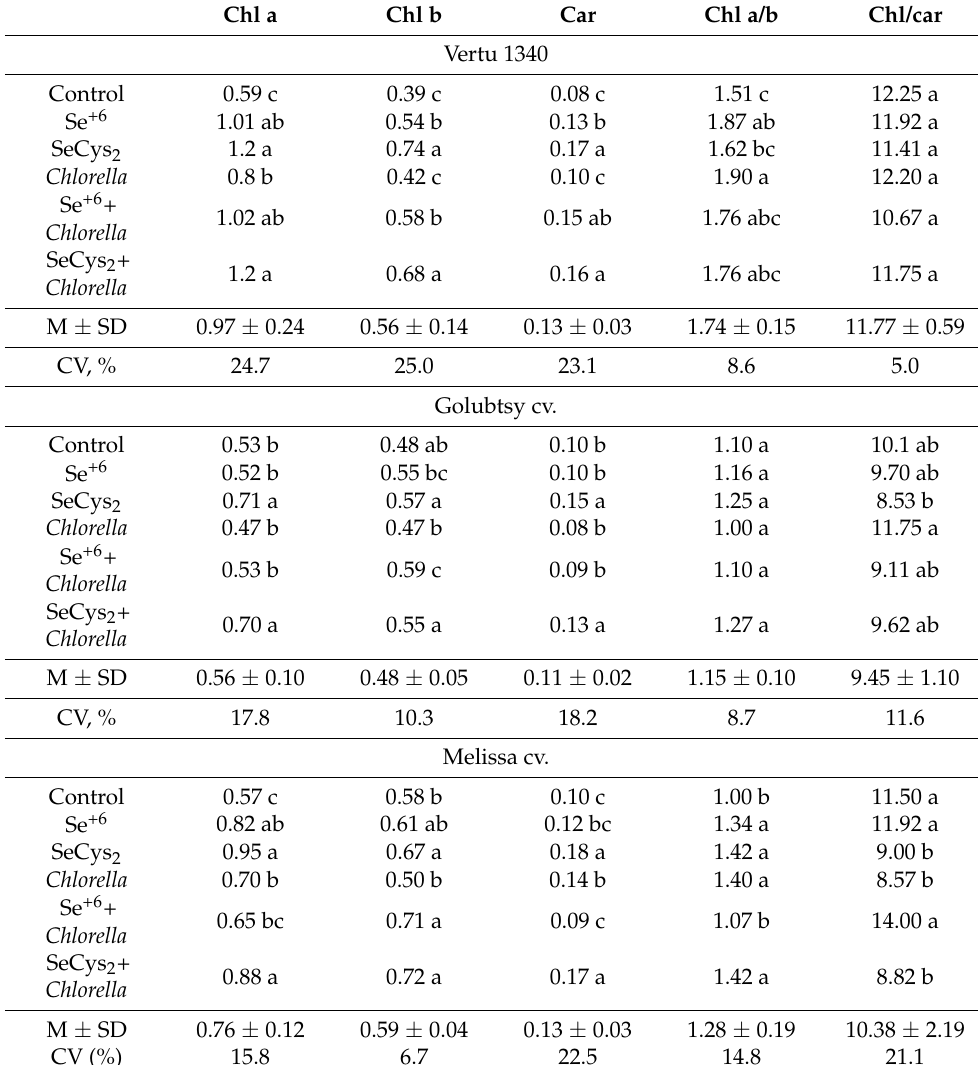
Table 2. Effect of Se biofortification under Chlorella supply on photosynthetic pigments accumulation in Savoy cabbage leaves (mg g − 1